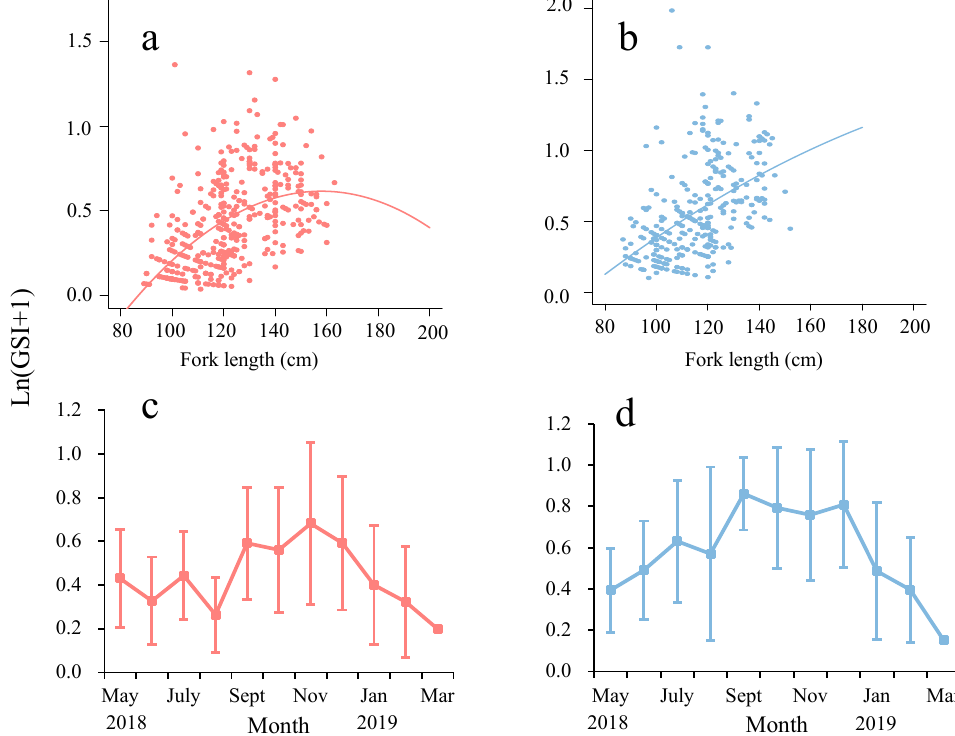
Table 1. Outputs of generalized linear model (GLM) fitting for gonadosomatic index (GSI) with biological and temporal factors. Significant p -values are formatted in bold (<0.05).